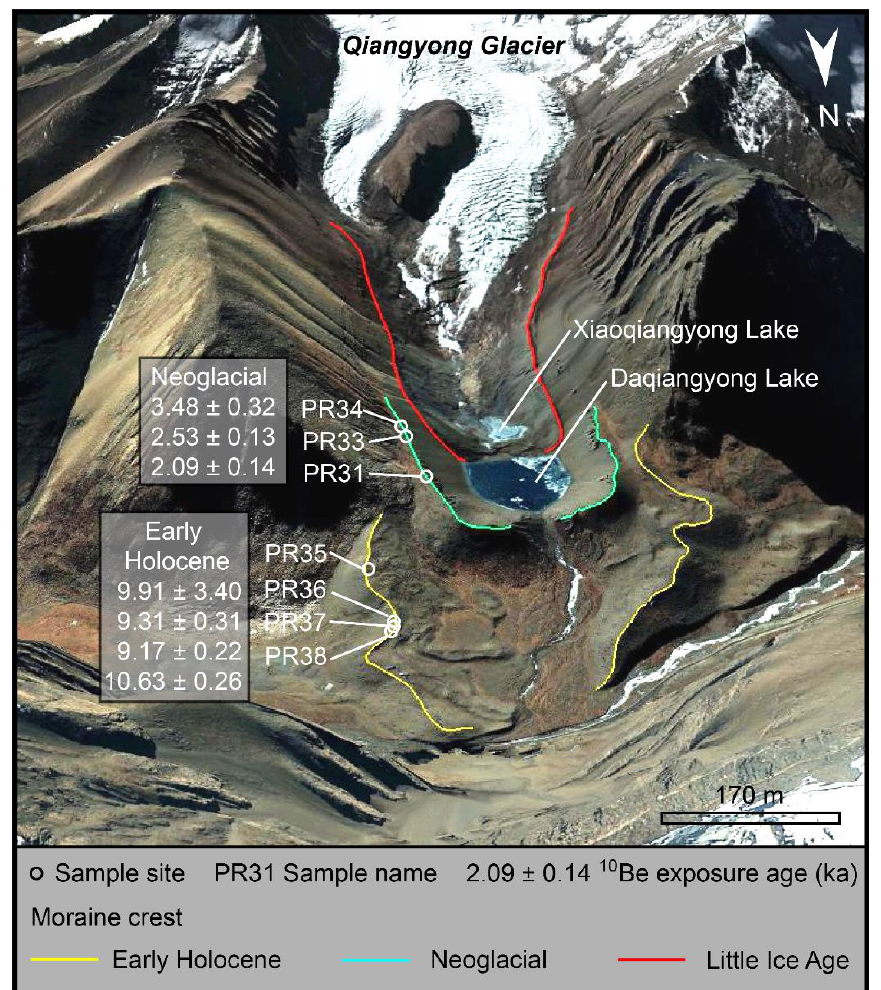
Figure 2. Oblique Google Earth image (vertical exaggeration = 1) showing lateral and frontal moraines in front of the Qiangyong Glacier. Age dating sample sites and 10 Be exposure ages from Owen et al. (2005) [18] were marked in the image.